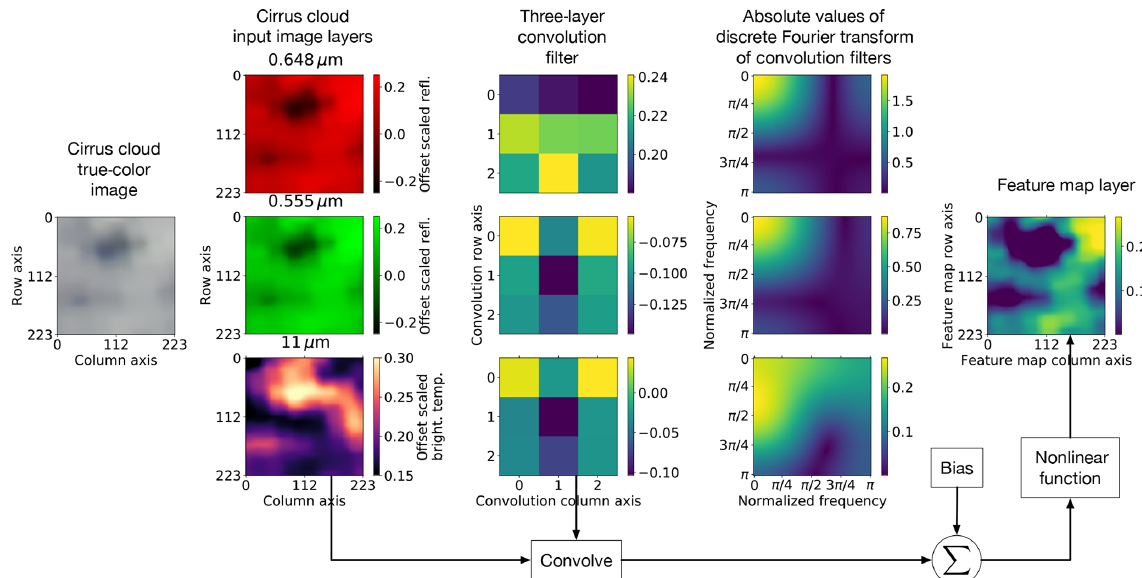
Figure 6. This figure shows an example of a feature map that is produced from a cirrus/high-altitude cloud image by a specific 3-dimensional (3D) convolution filter of the first layer of a convolutional neural network (CNN). The layers of the 3D filter are low- and band-pass filters as indicated by the discrete Fourier transforms (DFTs). The 3D convolution filter is convolved over the input image; for each convolution sum a bias term is added and then passed through a nonlinear activation function which corresponds to a feature map pixel. For this example the feature map highlights the local high-reflectivity and clear-air regions in the cirrus/high-altitude cloud.